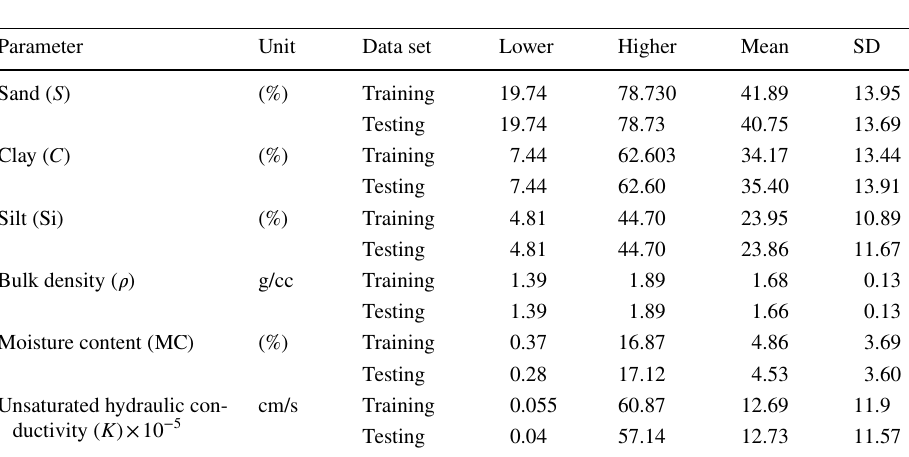
Table 2 Characteristics of training and testing data sets